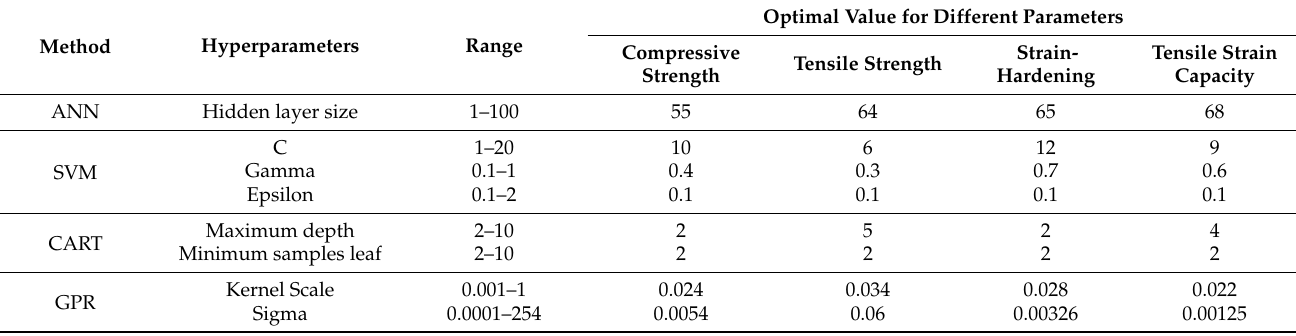
Table 2. The optimal hyperparameters for ML models.